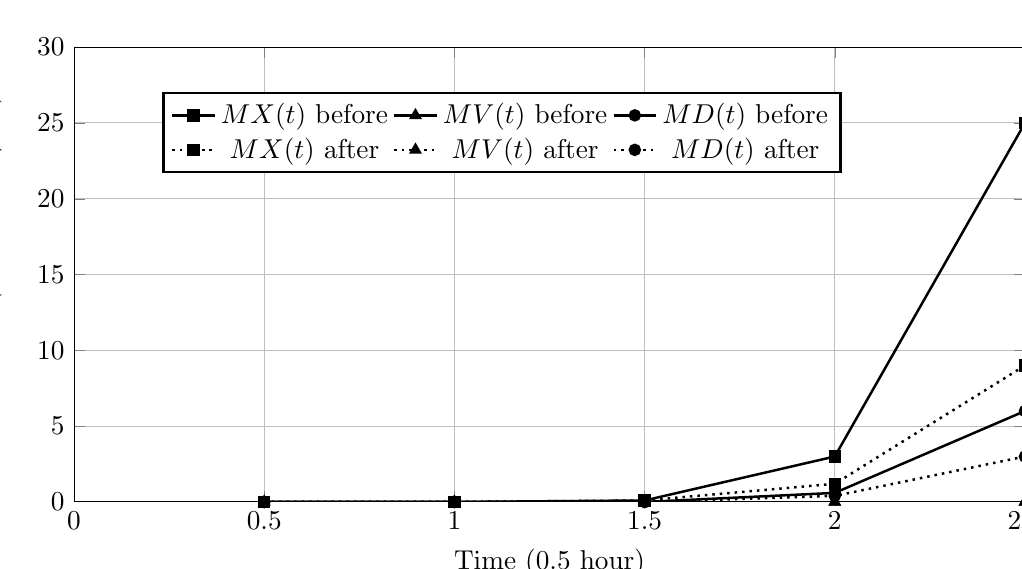
Figure 1: Simulated mean number of free HIV, infectious free HIV and non-infectious free HIV before and after combined therapeutic treatment. (Units: On the horizontal axis 0.5 is 1 hour, while on the vertical axis viral counts are measured in copies/m (cid:96) of